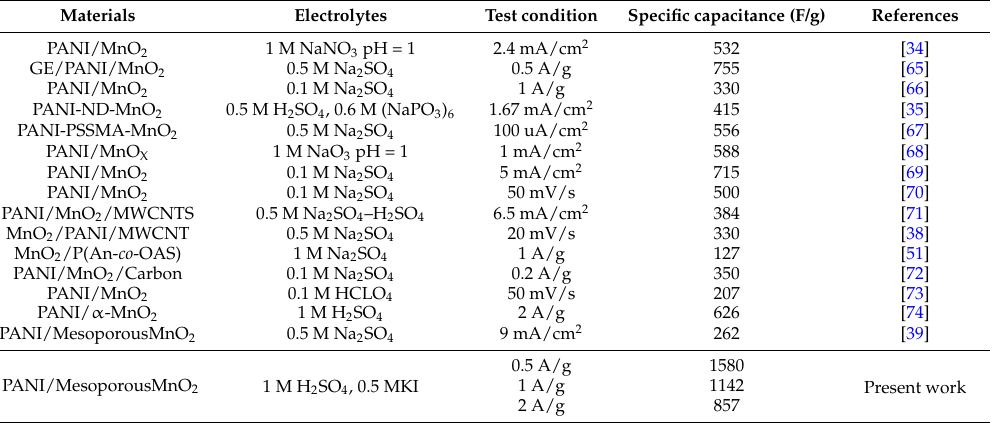
Table 1. Comparison of specific capacitance of PANI/ Mesoporous MnO 2 with reported values.